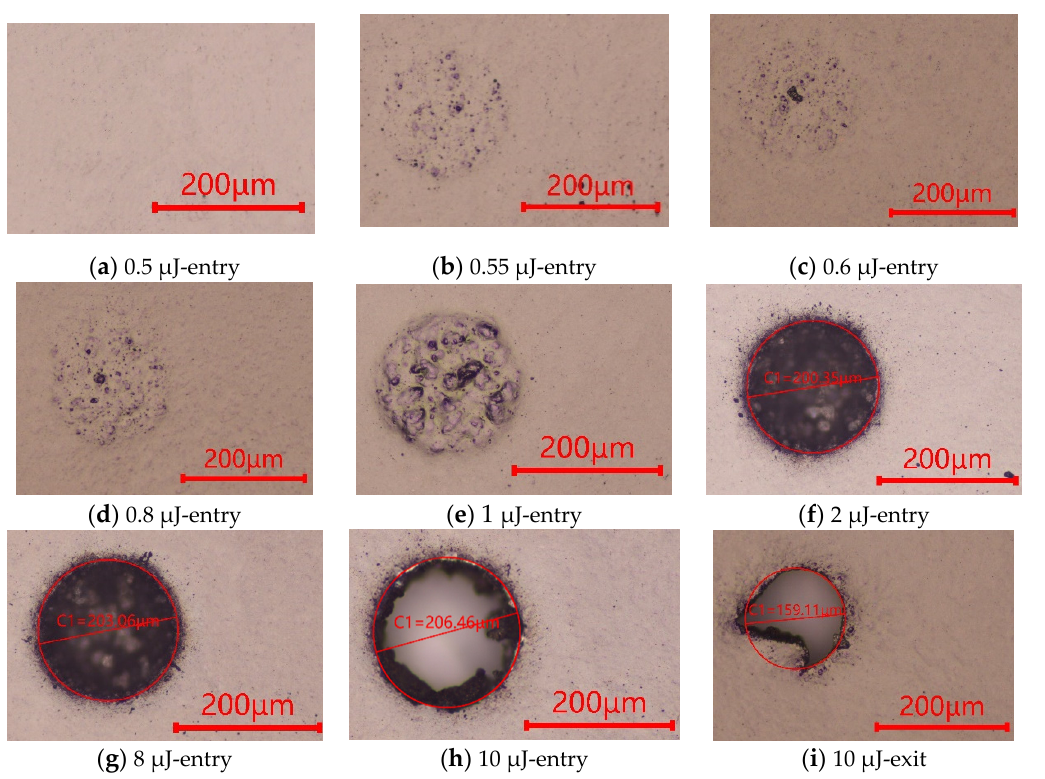
Figure 6. Geometric profiles of the microholes generated with different laser pulse energy; ( a ) entry hole at the energy of 0.5 μ J; ( b ) entry hole at the energy of 0.55 μ J; ( c ) entry hole at the energy of 0.6 μ J; ( d ) entry hole at the energy of 0.8 μ J; ( e ) entry hole at the energy of 1 μ J; ( f ) entry hole at the energy of 2 μ J; ( g ) entry hole at the energy of 8 μ J; ( h ) entry hole at the energy of 10 μ J; ( i ) exit hole at the energy of 10 μ J .